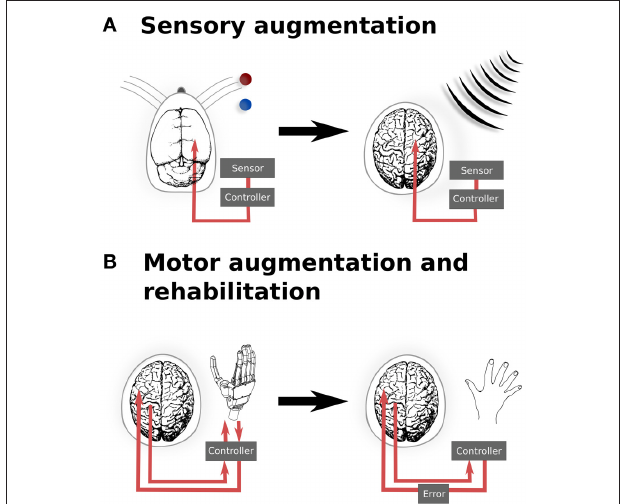
FIGURE 1 | Translation from experimental and existing therapeutics to clinical applications of neural augmentation using optogenetics. (A) Manipulation of somatosensory codes has been achieved in mouse barrel cortex, whereby optogenetically perturbing the sensory code caused the mouse to incorrectly report the location of the real bar as being in the blue position when the correct location was the red position ( O’Connor et al., 2013). In a similar manner, directly interfacing into human somatosensory when an external sensor detects signals that are imperceptible for humans, such as electromagnetic radiation, may allow for additional sensory capabilities. (B) Currently, BMI applications only offer the possibility of open-loop applications, by reading neural activity to drive interfaces. Optogenetics could potentially extend BMI to provide currently sensory feedback from the prosthetic back, thus closing the feedback loop (left). This could be extended to refine motor control (right), by supplying an additional sensory error which has been proposed to improve motor rehabilitation following stroke (Wei et al., 2005; Celik et al., 2009). Together, these applications highlight the potential to develop applications from both animal models as well as existing applications, such as BMI. Images: prosthetic hand taken from Patent US Patent App. 10/488,008. Human brain (Wikimedia Commons); Mouse brain (Green,